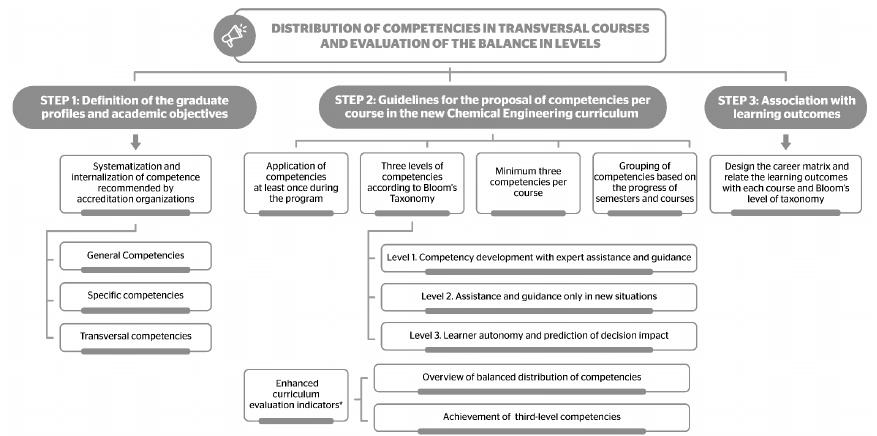
Fig. 6. Methodology for the definition and analysis of competences and learning outcomes